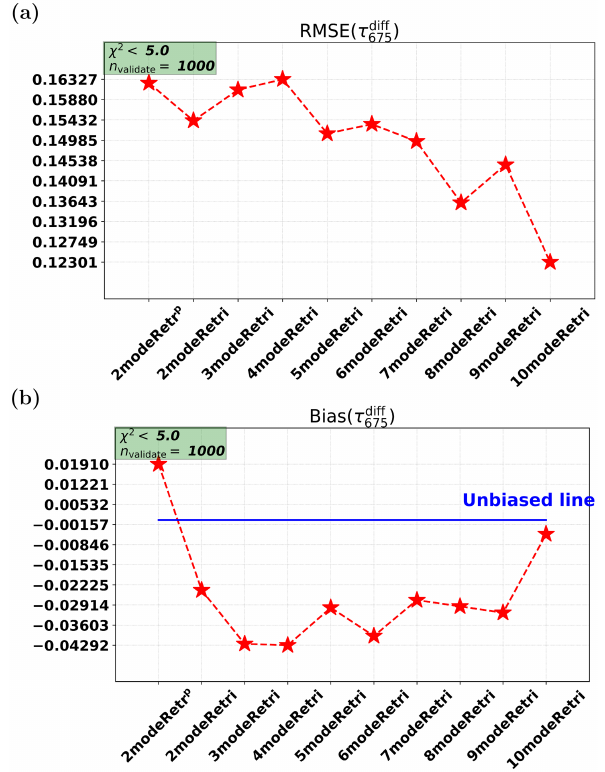
Figure 14. Real data retrievals for AOT: root-mean-square error (RMSE) and bias for the difference between PARASOL retrievals and AERONET